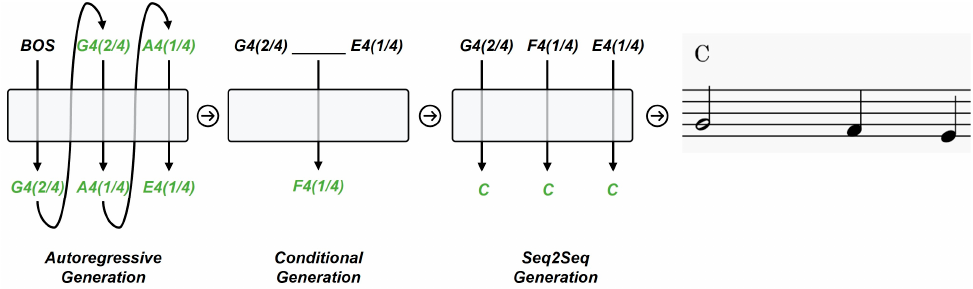
Figure 6. Human–interactive use case of automatic music generation.